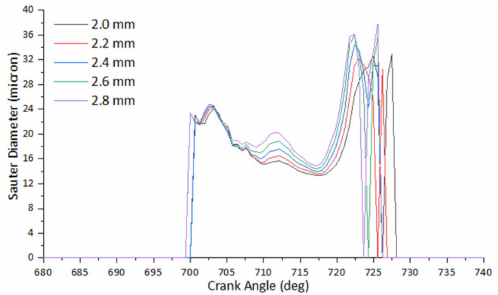
Figure 11. Fuel SMD under varied pipe